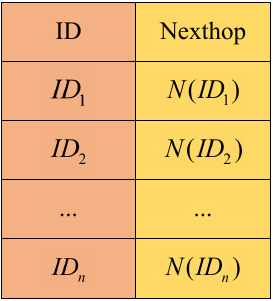
Figure 2. Fields of upward data packets.